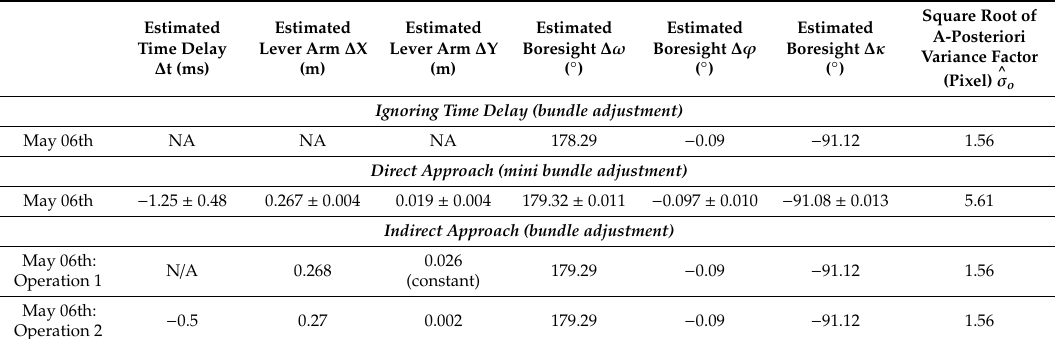
Table 14. Estimated parameter results for the DJI M600 platform, including the standard deviations for the direct results.